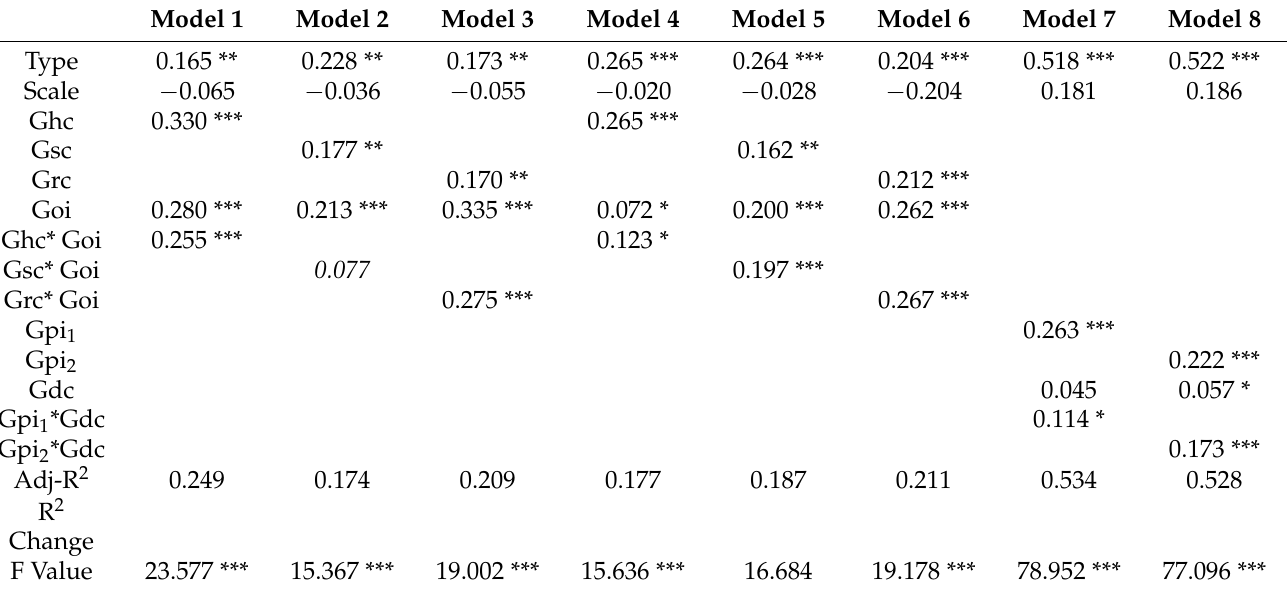
Table 6. The moderation effect of Goi and Gdc regression